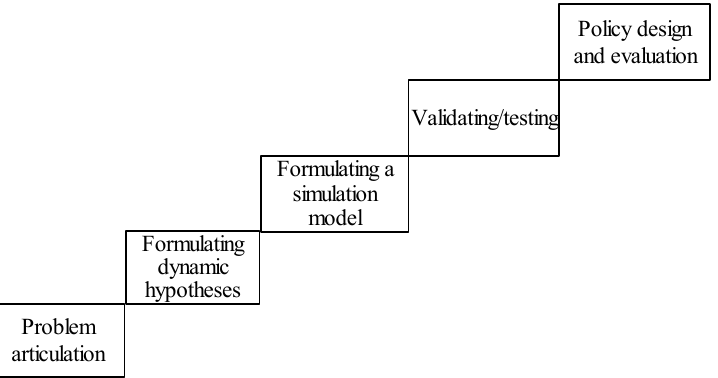
Figure 3. The steps for systems thinking and systems dynamics.